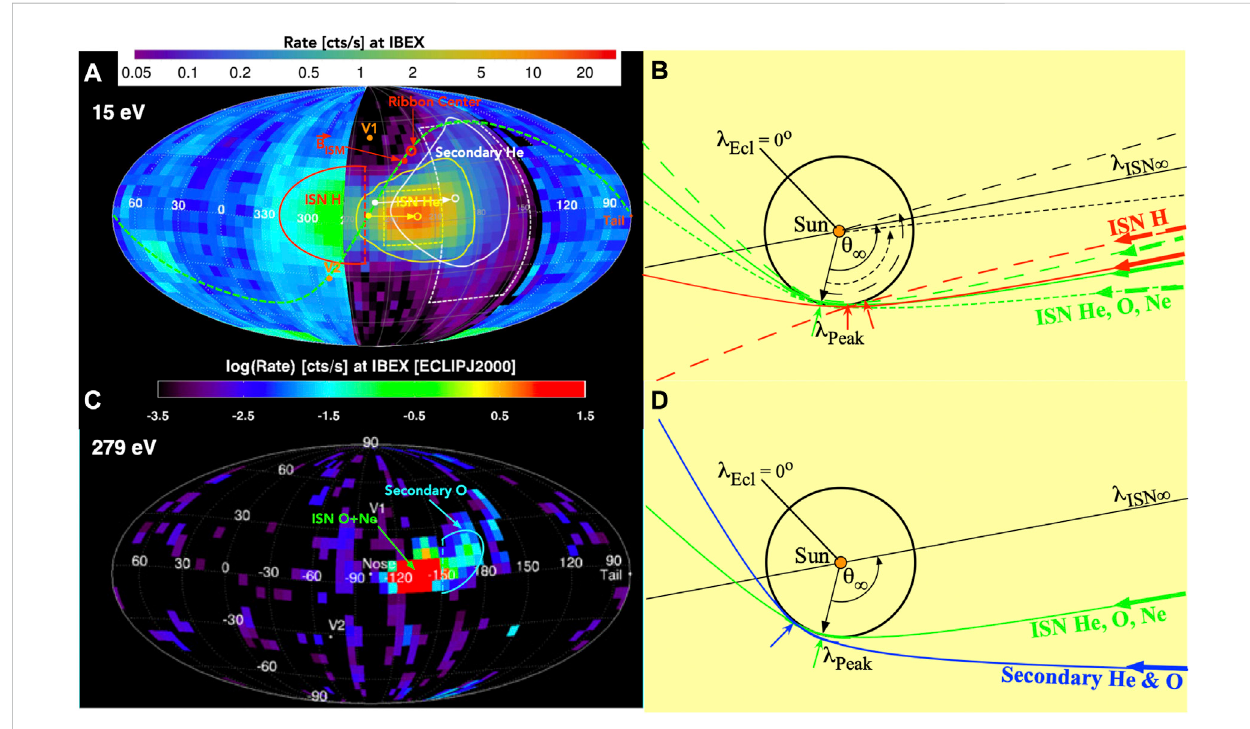
FIGURE 2 Left: Combination of IBEX ENA maps in Mollweide projection that illustrate the interstellar medium information collected at 1 AU. Right: Schematic viewoftheISNandENAtrajectoriesfromtheirsourcetotheobserverat1 AU. (A) ISNHeandH fl owbasedonHcountratesat15 eV,alongwithsecondary Heneutrals[adaptedfrom(Parketal.,2016;Swaczynaetal.,2018)],reproducedwithpermissionfromAAS. (B) SchematicrepresentationofISNHe,O,and Ne (green), as well as H (red) trajectories in the plane that contains (cid:1) V ISN ∞ , the Sun, and the in-ecliptic location λ Peak where the bulk ISN fl ow is observed atits perihelion. The ISN fl ow arrives from λ ISN ∞ attheheliopause, whose value isconnected throughtheangle sweptout bythe arriving atoms fromin fi nitytoperihelionortrueanomaly θ ∞ to λ Peak and V ISN ∞ inEq.1;Eq.1describes unboundKepleriantrajectories. Itdescribes V ISN ∞ asafunctionof λ ISN ∞ (samples shown as dashed green lines) for the observed value of λ Peak . An extended range of observer locations for the angular distribution of the ISN fl ow around the peak constrains λ ISN ∞ and V ISN ∞ separately. For ISN H, λ Peak shifts to larger ecliptic longitude due to the partial compensation of gravitation by solar radiation pressure, increasingly during high solar activity (dashed red) (Rahmanifard et al., 2019). (C) ISN O and Ne fl ow based on O count rates at 279 eV, along with secondary O neutrals [adapted from (Park et al., 2015)], reproduced with permission from AAS. (D) Same representation as above for the ISN fl ow (green) and secondary neutral distributions (blue), whose arrival directions at the heliopause and λ Peak at 1AU are shifted to a smallerlongitude.Inthemaps,theISNHe,O,andNe fl owarrivesfromthesamedirectioninthesky,de fl ectedwestwardfromthearrivaldirectionoutside the heliopause (shown as a yellow dot in panel A) due to the Sun ’ s gravitation. In contrast, the ISN H fl ow is de fl ected eastward due to radiation pressure. The arrival directions of theISN fl ow(yellow dot)and secondaryHe (whitedot),the Ribboncenter (open red circle), and thederived (cid:1) B ISM directionlineup along the (cid:1) B ISM — (cid:1) V ISN plane (the dashed green